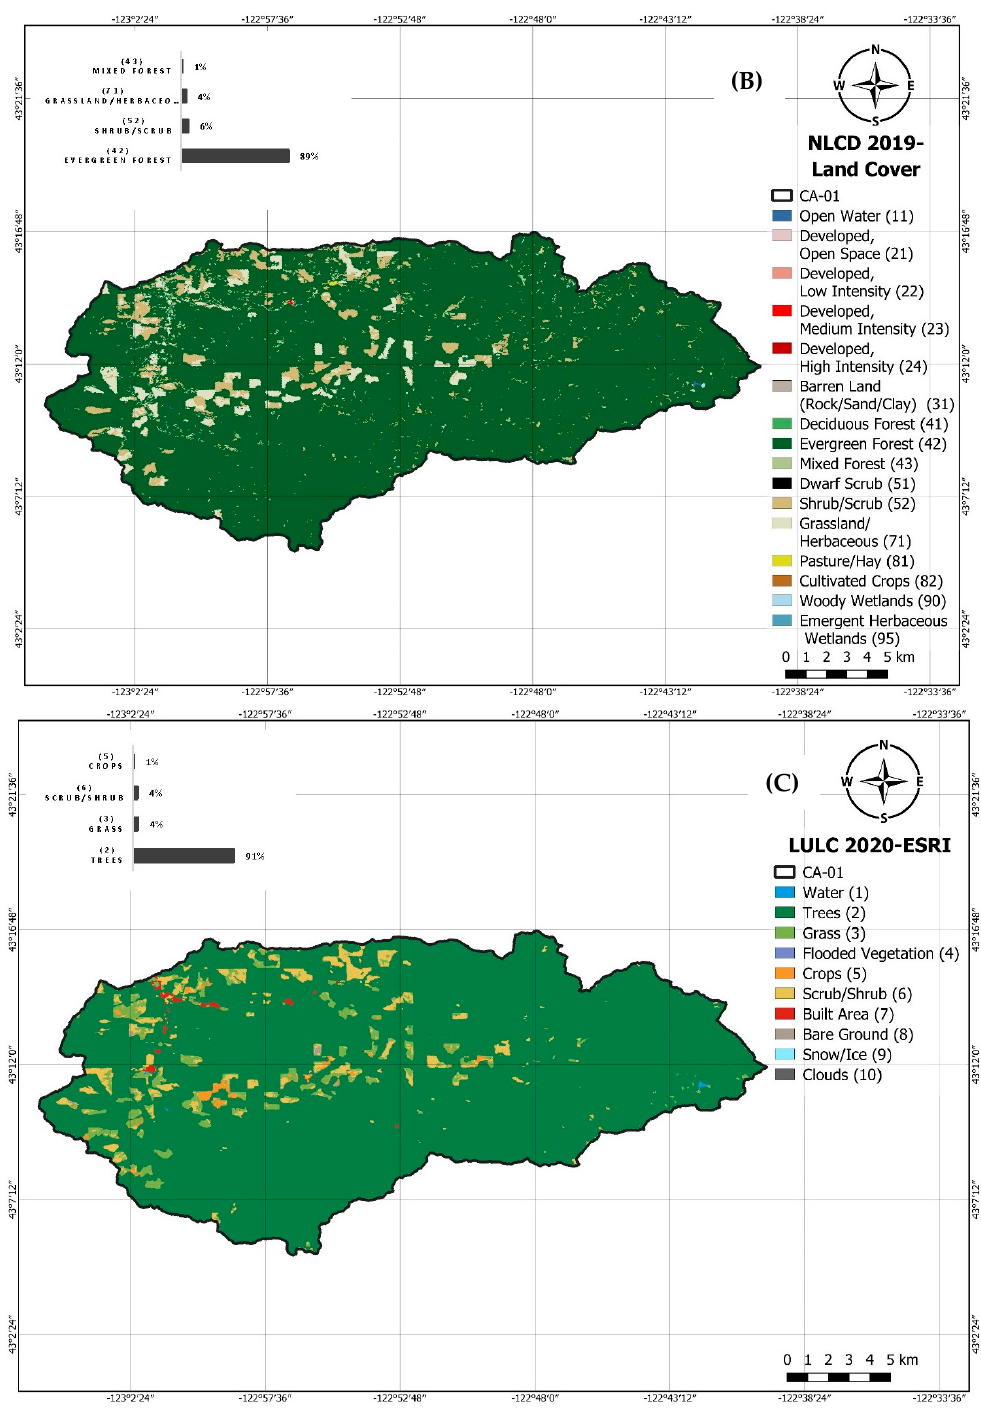
Figure 10. DEM and land-use maps for Catchment CA-01 ( A ) DEM, ( B ) NLCD 2019 land-use map, ( C ) LULC 2020-ESRI land-use map.